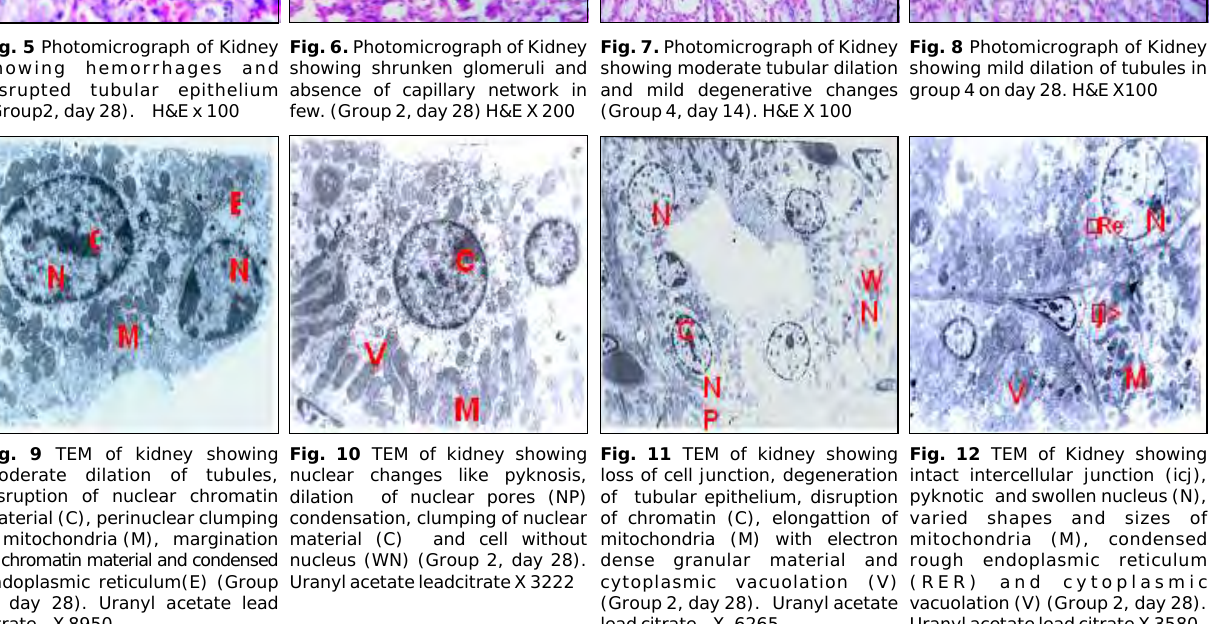
Fig. 8 Photomicrograph of Kidney showing mild dilation of tubules in group 4 on day 28. H&E X100